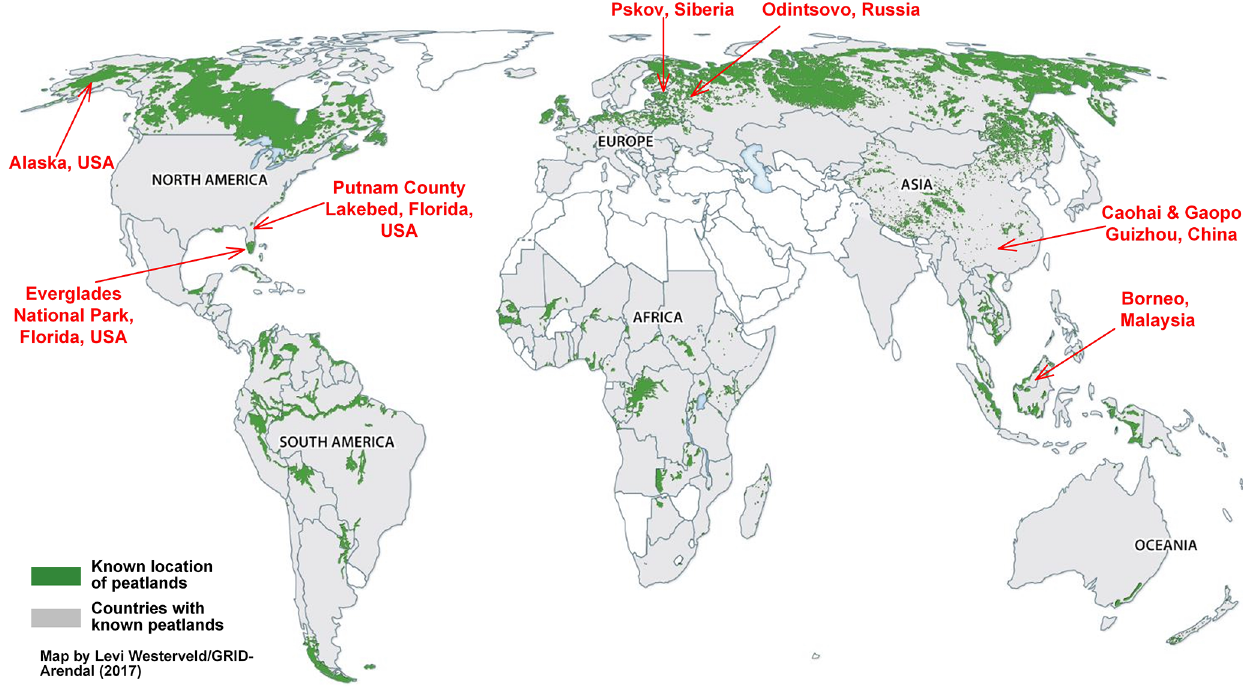
Figure 1. Global distribution of peatlands (based on Yu et al., 2010). Samples were obtained from Odintsovo, Russia; Pskov, Siberia; black spruce forest, northern Alaska, USA; Putnam County Lakebed and Everglades National Park, Florida, USA; Caohai and Gaopo, Guizhou, China; and Borneo,